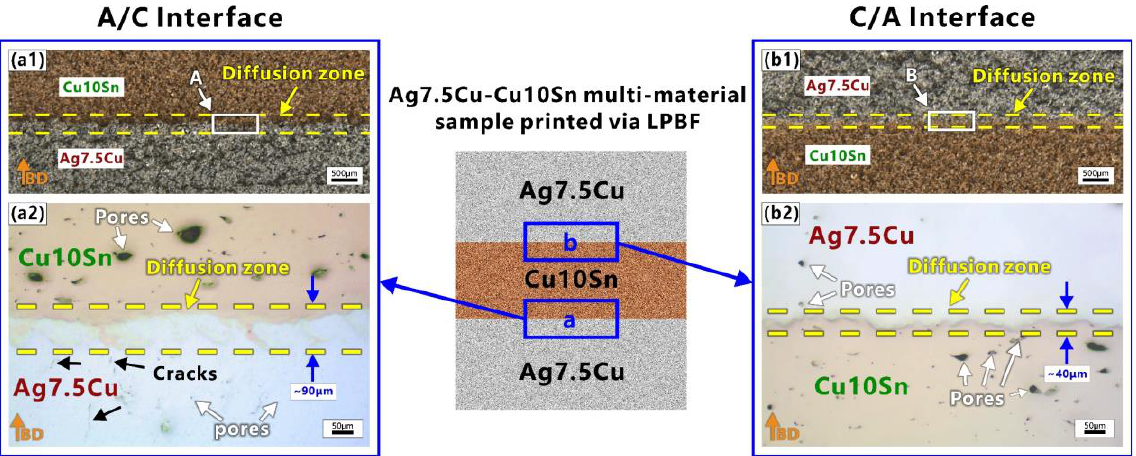
Figure 3. Optical images of two interfaces: ( a1 ) macroscopic images of the A/C interface; ( a2 ) en- larged view of area A in ( a1 ); ( b1 ) macroscopic images of C/A interface; ( b2 ) enlarged view of area (B) in ( b1 ). Orange arrows indicate the building direction (BD).